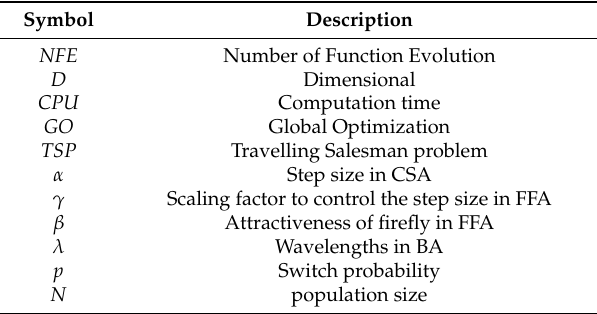
Table 1. Symbols and